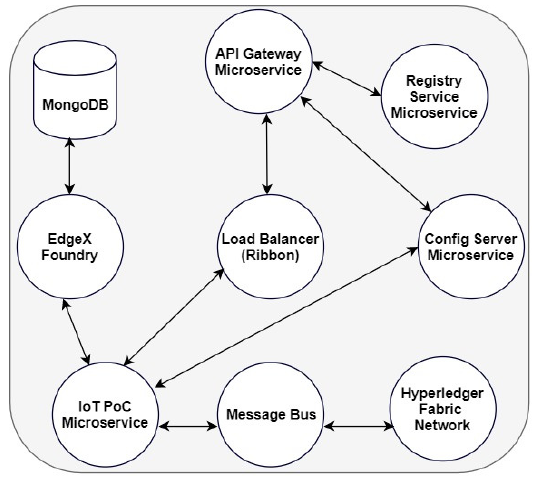
Figure 5. Implementation approach.